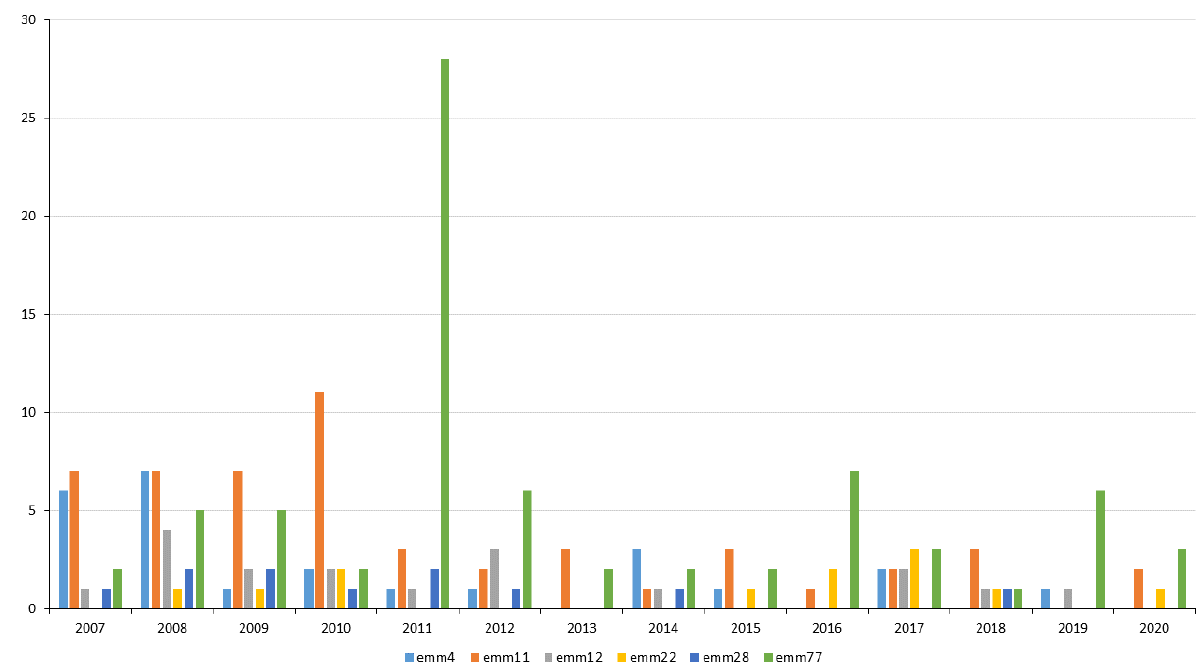
Figure 3 . Change over time in antimicrobial resistance in Streptococcus pyogenes . Rates of tetracycline, erythromycin, and clindamycin resistance distributed ( a ) yearly and ( b ) by 4 – 5-year periods. R, re- sistance. Vertical axis = number of isolates. Total R represents the sum of the resistant isolates.